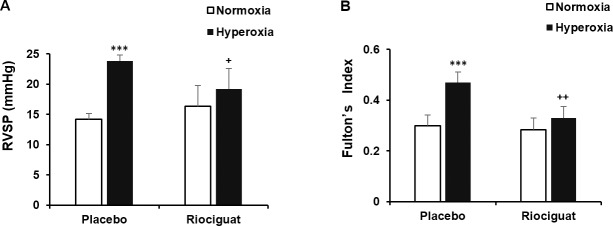
Riociguat reduces hyperoxia-induced PH.(A) Right ventricular systolic pressure (RVSP) was significantly increased in the hyperoxia + placebo treated group as compared with normoxia group. Riociguat administration significantly decreased RVSP during hyperoxia. ***P < 0.001 compared with normoxia; +P < 0.05 compared with hyperoxia + placebo (n = 6/group). (B) Right ventricular hypertrophy (RVH), also known as the Fulton’s index, was determined by the weight ratio of right ventricle (RV) to left ventricle + septum (LV + S). Hyperoxia exposed animals in the presence of placebo showed significant RVH as compared with normoxia group. Administration of riociguat decreased RVH in hyperoxia exposed lungs. ***P < 0.001 compared with normoxia; ++P < 0.01 compared with hyperoxia + placebo (n = 6/group).